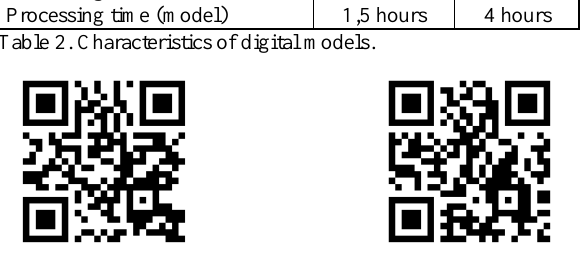
Figure 6. Links to the renders through QR codes.